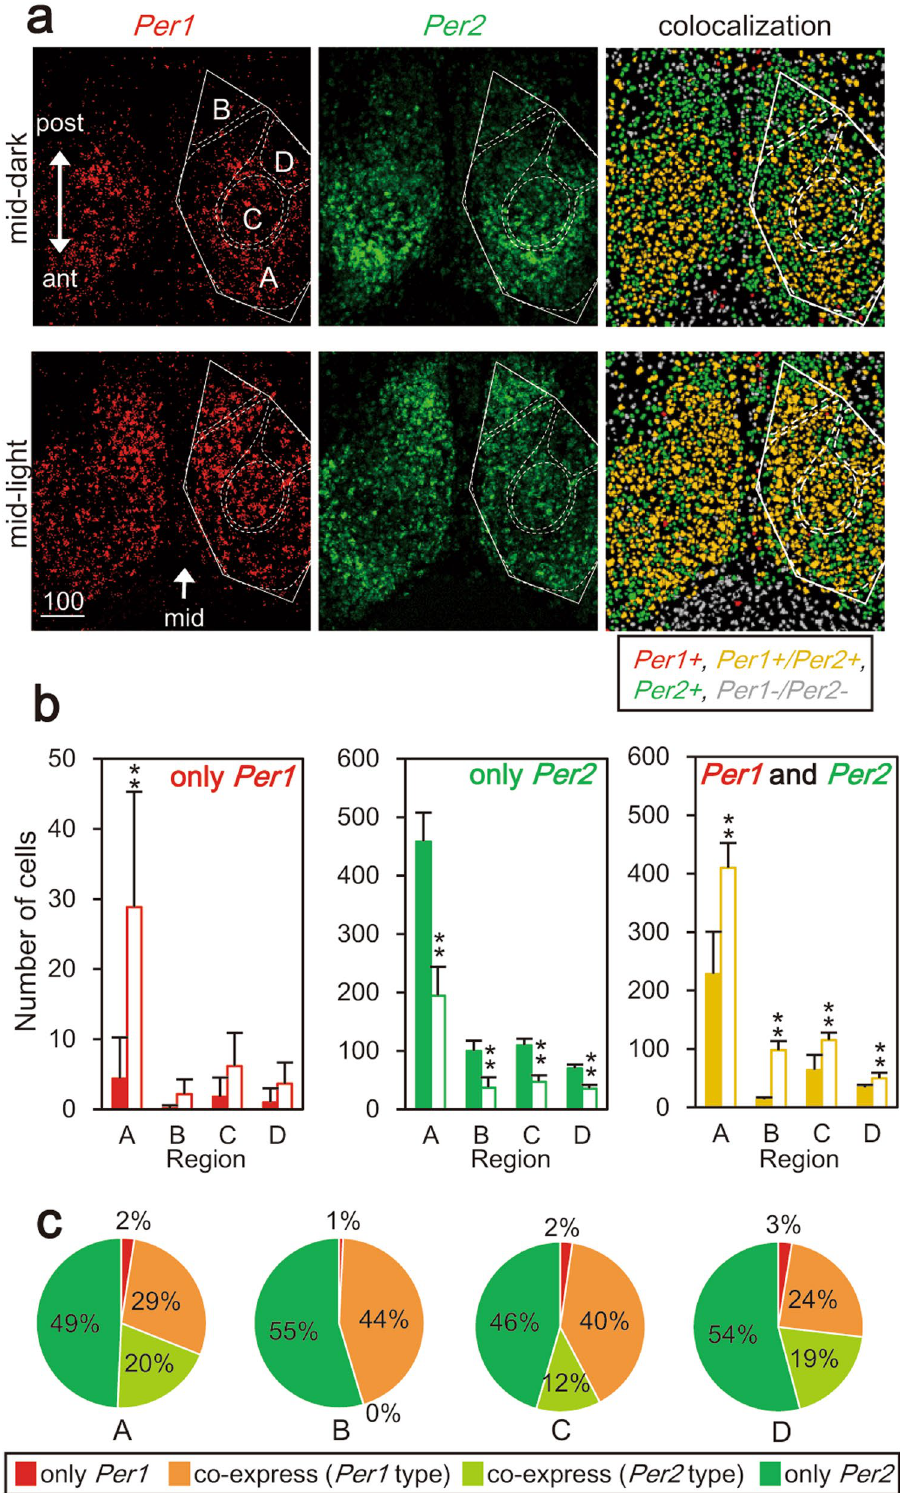
Figure 7. Distributions of Per1 and Per2 mRNA in the horizontal SCN slice. ( a ) Representative images of Per1 (left, red) and Per2 (middle, green) mRNA positive signals at the mid-dark (0:00 h in local time) and mid-light (12:00 h in local time) by double labeled in situ hybridization. Co-expression is shown in the right where double-positive and -negative cells are shown in yellow and grey, respectively. White solid and dashed trace lines are the margin of the SCN and of each SCN region (Fig. 3e), respectively. ( b ) Numbers of only Per1 , only Per2 and Per1/Per2 expressing cells at the mid-dark (n = 5, filled bar) and mid-light (n = 6, open bar) are demonstrated in reach SCN region (mean and SD). The numbers of only Per1 and only Per2 expressing cells were obtained from the total numbers of Per1 , Per2 and Per1/Per2 expressing cells. ** P < 0.01, * P < 0.05,